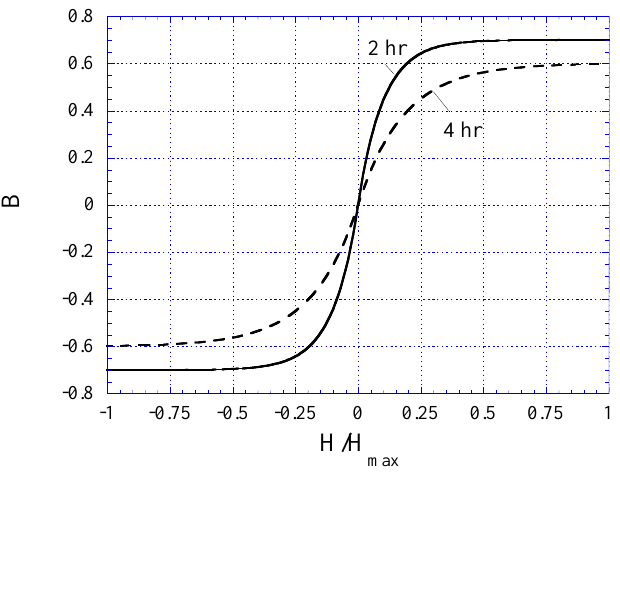
Figure 6 plots the BH curves modeled with Equation (1). To fit to the measured BH curves of 2 and 4 h plated samples, the value of k in Equation (1) was determined as 12 and 6 for 2 and 4 h samples, respectively. The 2 and 4 h curves were also normalized by a factor of 0.7 and 0.6, respectively. The 2nd-order harmonic fields of the 2 and 4 h samples were determined using Equation (3) and plotted in Figure 7. Although the modeled 2nd-order harmonic fields showed the same trend as the measured 2nd-order harmonic fields, there were observable differences caused by variations between the actual and modeled curvatures of the BH plots. Nevertheless, the model provided a simple technique to predict the higher-order fields of soft magnetic materials based on their BH curves. Figure 6. Exponential functions best-fitted to the BH loops of the 2 and 4 h plated nickel-iron alloy